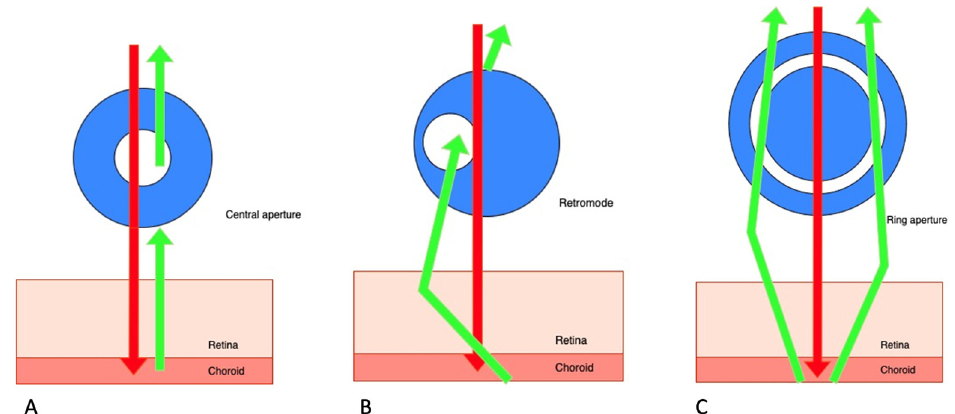
Figure 1. Scanning laser ophthalmoscope: three different aperture types: ( A ) confocal (with a central aperture). ( B ) retromode (with a laterally deviated aperture to the left or to the right), and, respectively, ( C ) the ring aperture.